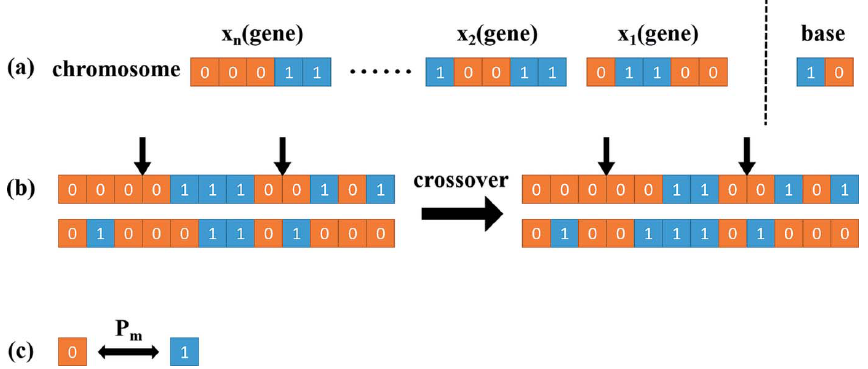
Figure 1 Binary encoding and genetic operators. ( a ) Parameters are converted to binary code. ( b ) The crossover operator. ( c ) The mutation operator with probability P m